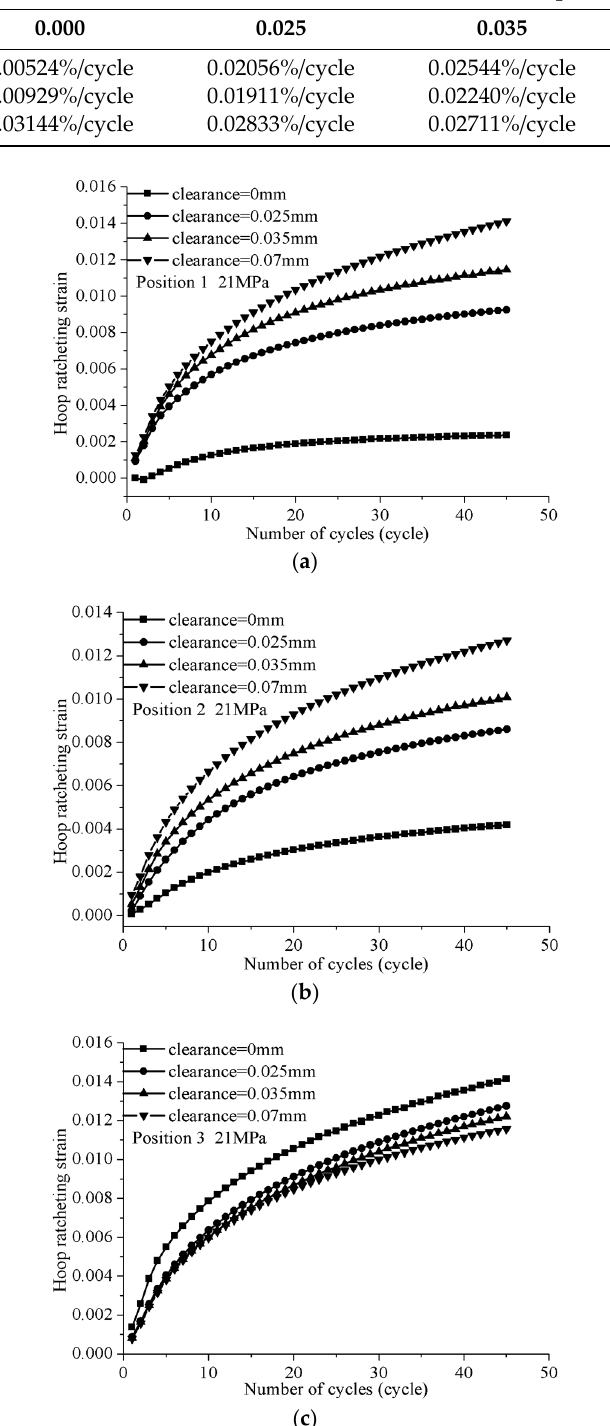
Figure 10. Ratcheting response for different clearance between the sleeve and the pipe under 21 MPa at different positions: ( a ) At Position 1, ( b ) at Position 2, and ( c ) at Position 3.